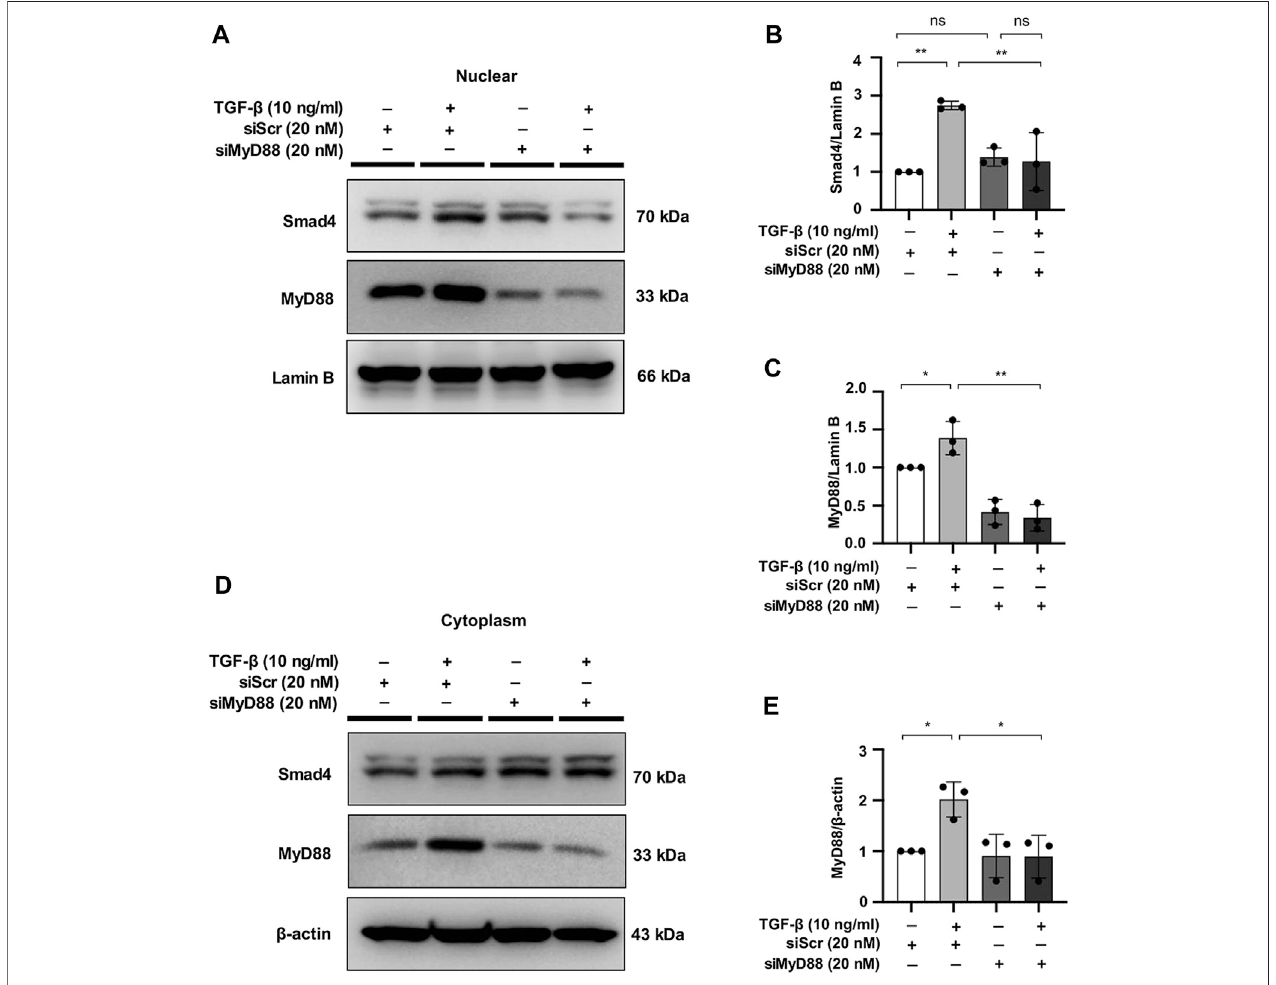
FIGURE 7 | MyD88 silencing hinders nuclear expression of Smad4 in TGF- β -stimulated NRK49F cells. (A,D) Western blotting revealed that Smad4 nuclear translocation was blocked by siMyD88 transfection in TGF- β -stimulated NRK49F cells. NRK49F cells were transfected with siMyD88 or siScr for 24 h in high-glucose DMEM without FBS, starved with 0.5% FBS medium, and then treated with TGF- β (10 ng/ml) for 30 min. Western blotting demonstrated that MyD88 expression was signi fi cantlyreducedbythespeci fi csiRNA.Cytoplasmic andnuclearproteinswereseparatedusingCER/NERbuffer. β -actinandLaminBindicatethecytoplasmic and nuclear fractions, respectively. (B,C,E) Statistical signi fi cance was presented as the mean ± SD, n (cid:1) 3. * p < 0.05, ** p < 0.01, ns: no signi fi cance. MA, maslinic acid; siRNA, small interfering RNA.